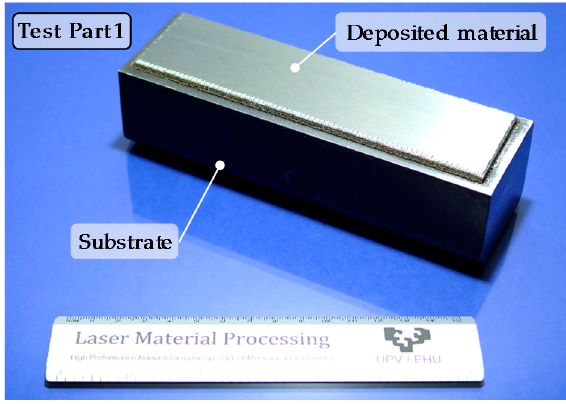
Figure 2. Test part 1 after the LMD and grinding processes.